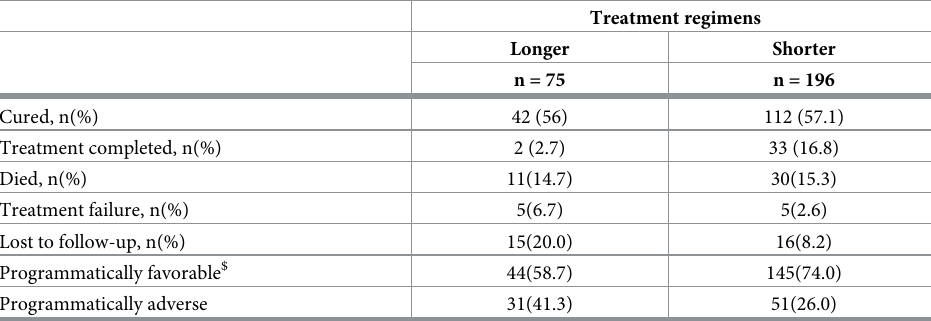
Table 2. Treatment outcomes among 271 patients started on MDR-TB treatment in Guinea, 2016 and 2017.